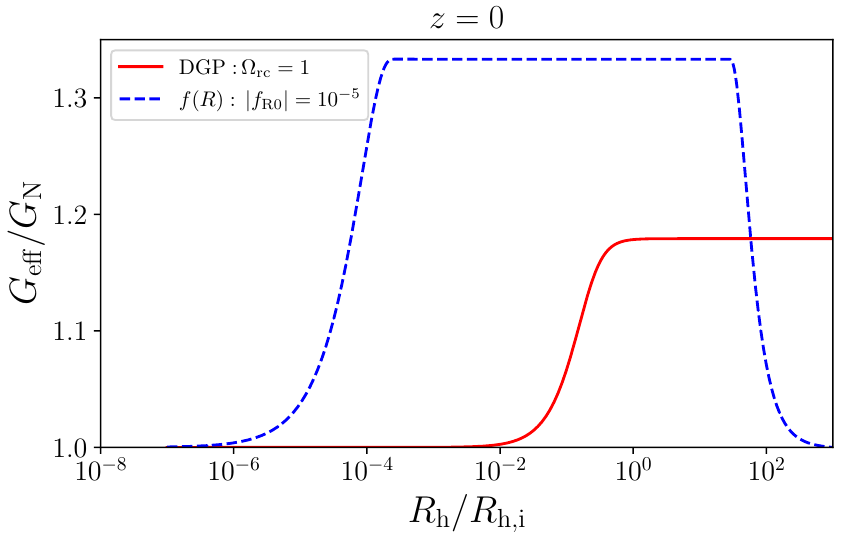
Figure 1. The normalized effective Newton’s constant as a function of dark matter halo radius R h in the chameleon screened Hu–Sawicki f ( R ) gravity ( blue, dashed ) and the Vainshtein screened DGP gravity ( red, solid ). R h, i is the initial size of the halo and Ω rc unscreened regime reflect the specific values of f R0 and r c